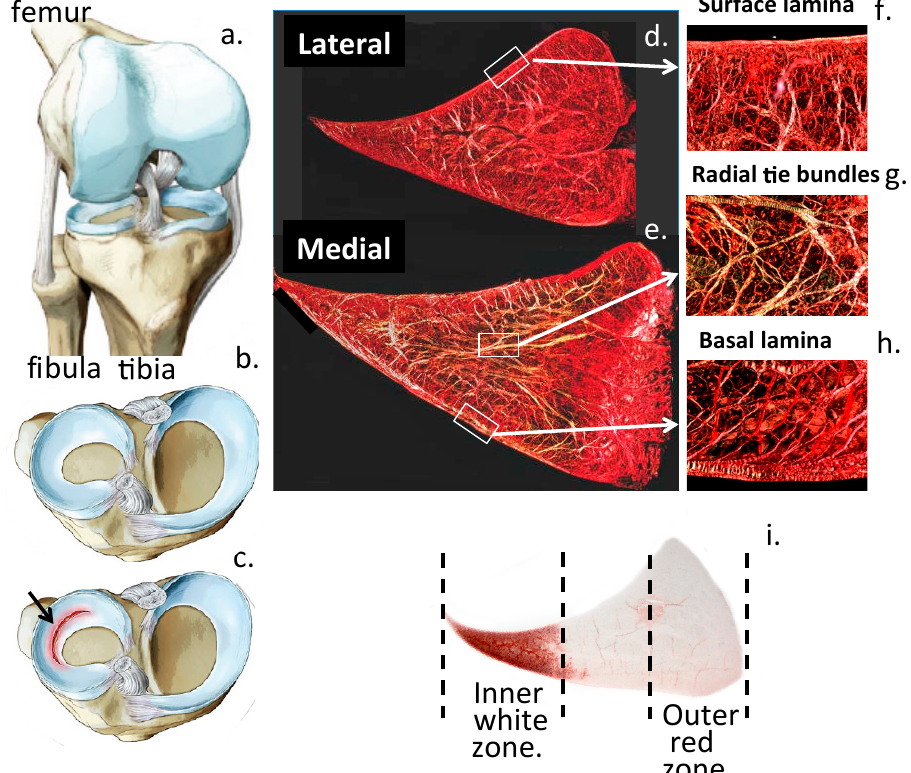
Figure 1. Knee anatomy showing the location of the knee joint menisci ( a , b ) with a radial tear arrowed ( c ) and the collagen fibre organisation of the menisci in vertical sections through lateral ( d ) and medial menisci ( e ) which equip these as weight bearing stabilising structures in the knee joint. Radial tie bundles and collagen fibrillar arrangements in the surface and basal meniscal laminas are also shown ( f – h ). The inner zone meniscal cells are cartilaginous whereas the outer zone meniscal cells are more fibrocartilaginous ( i ). This is clearly evident in the focal localisation of the HS-proteoglycan perlecan which is a chondrogenic marker [10]. Figure modified from [18] with permission of InTech Open Publishers: London. Figure copyright J.